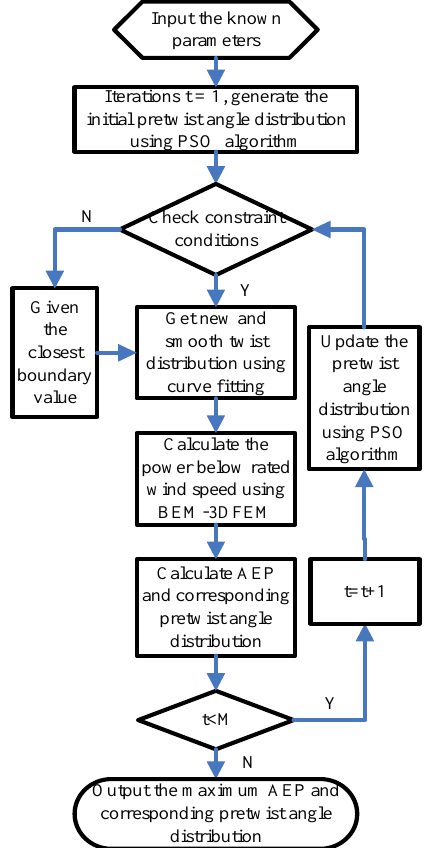
Figure 4. The flow chart of the aeroelastic coupling optimization model.